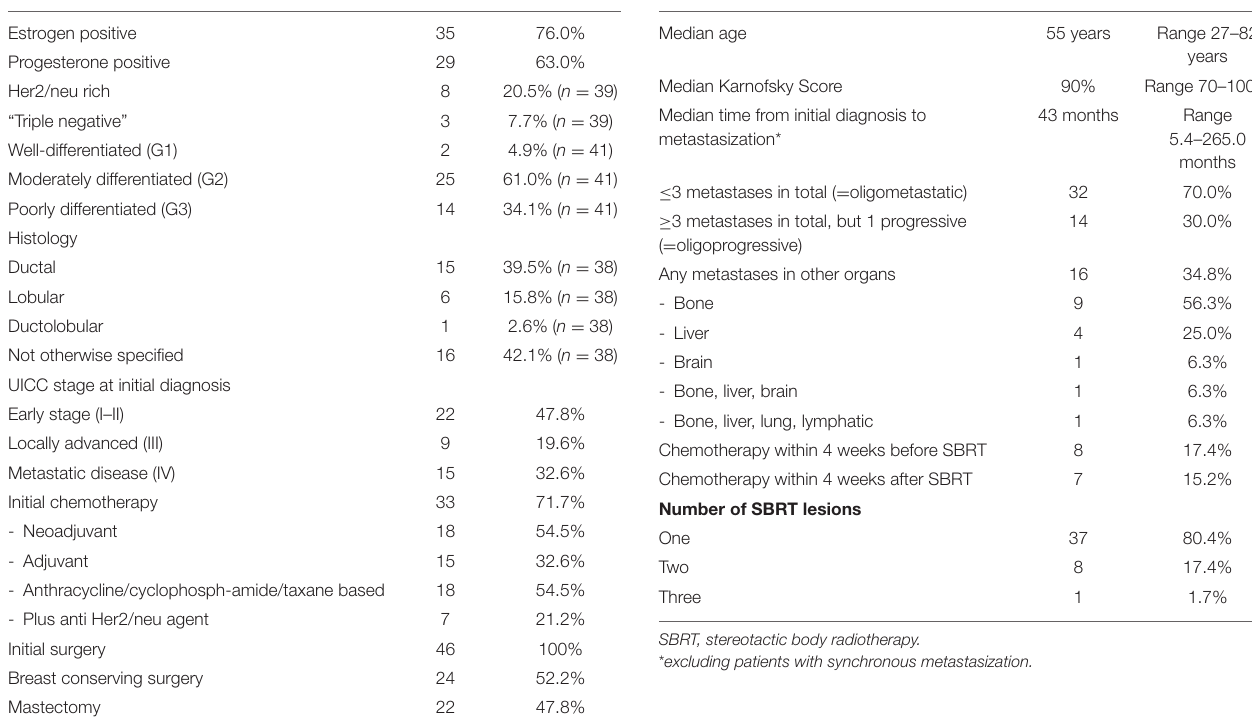
TABLE 1 | Analysis of patient characteristics at initial diagnosis. TABLE 2 | Analysis of patient characteristics at time of or after